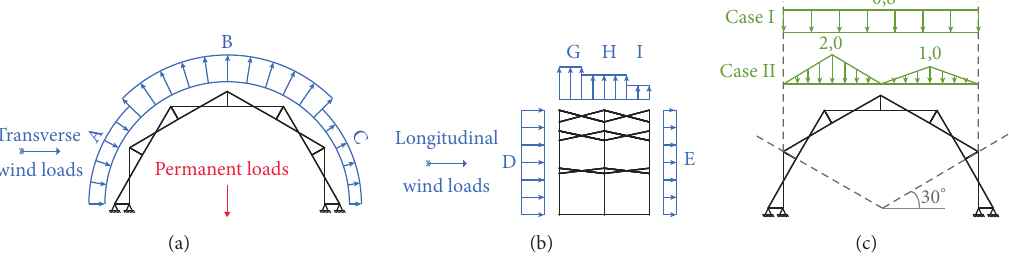
Figure 3: The transverse wind load causes pressure in one zone and suction in the two other zones (a). The longitudinal wind load causes a pressure in Zone D and suction in Zones G, H, I, and E (b). Two snow loads are considered, a uniform and a drifted one (c).